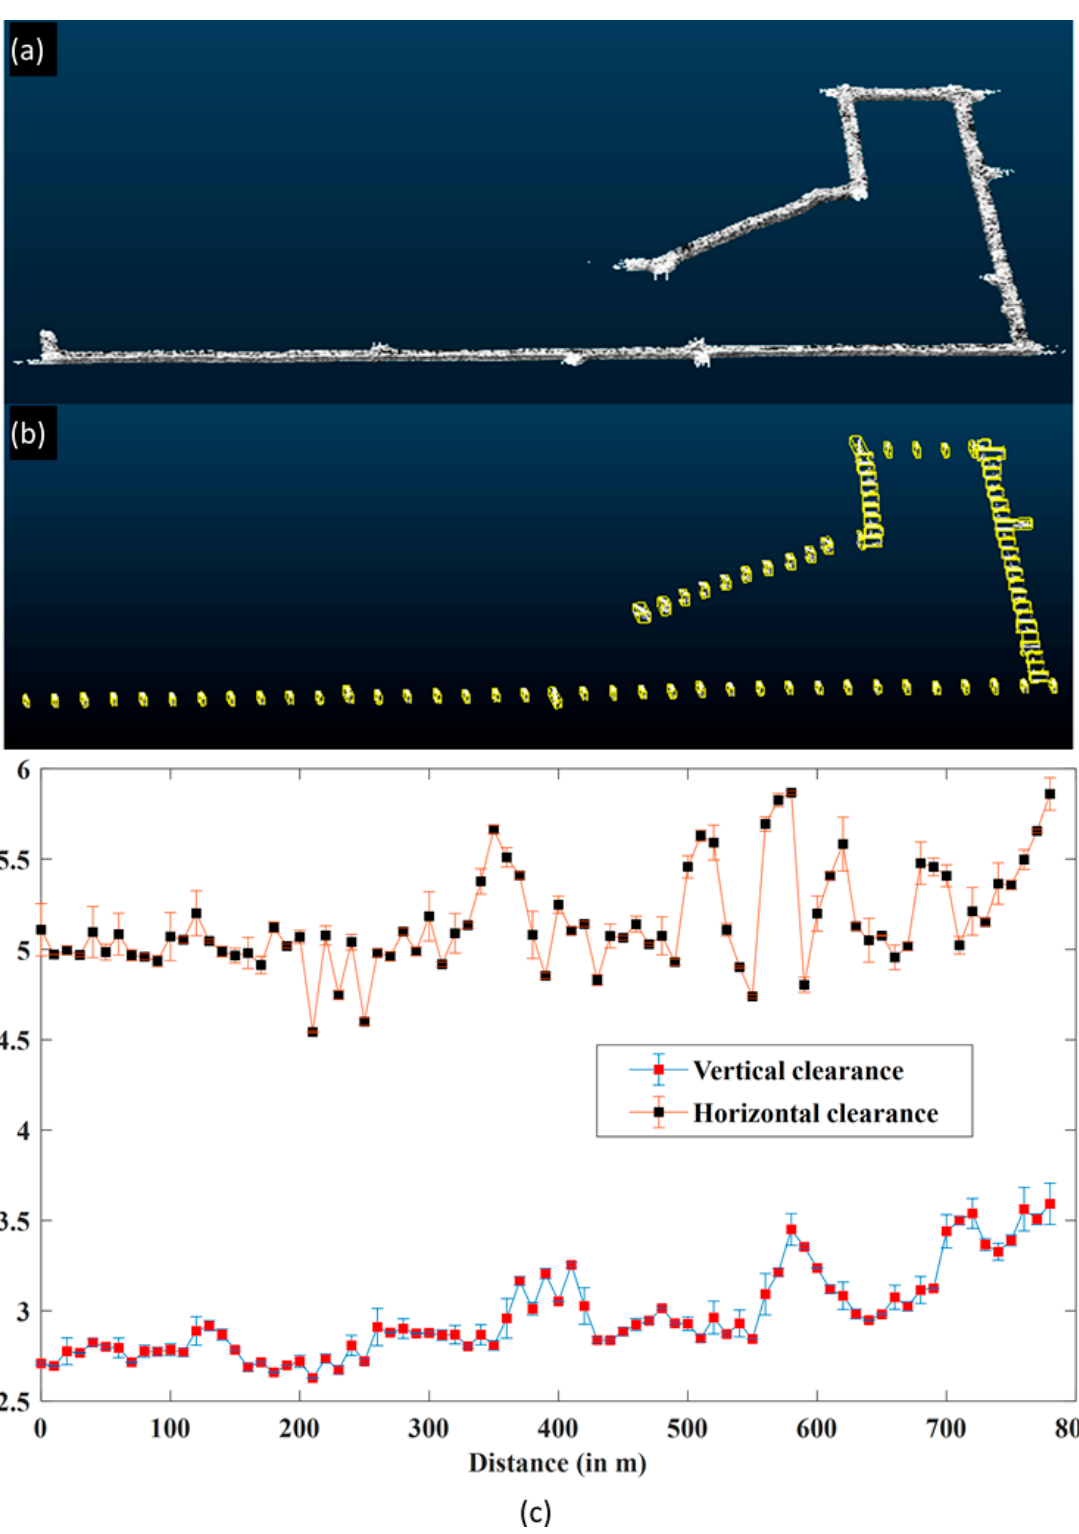
Figure 10. ( a ) Point cloud of the test area, ( b ) cross-sections extracted at every 10 m starting from the first 3DUID and ending at last 3DUID, and ( c ) the observed error in actual vertical and horizontal clearance shown with box plot for the given length of the mine